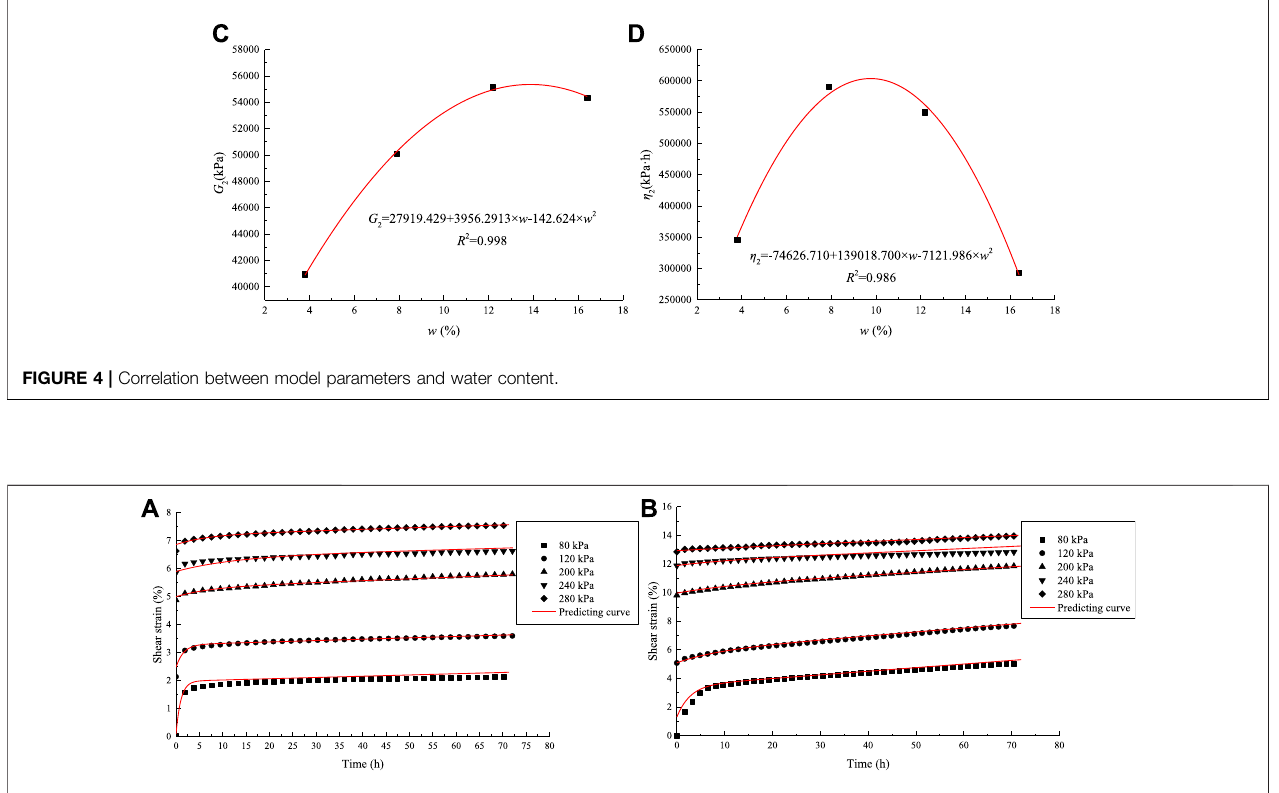
Frontiers in Physics |